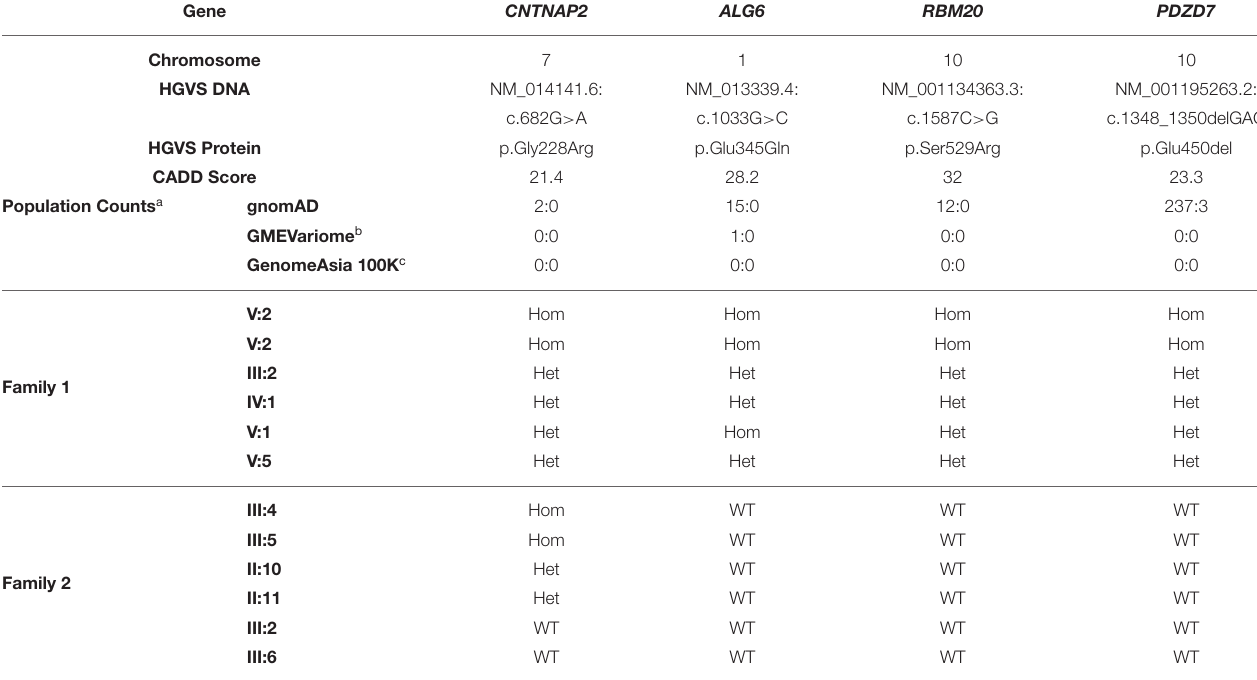
TABLE 2 | Segregation of candidate variants.